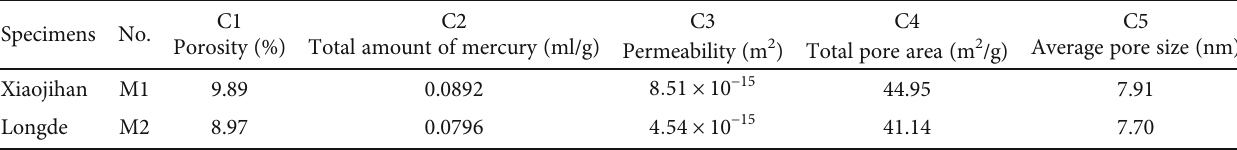
Table 1: The experiment results of mercury intrusion tests.